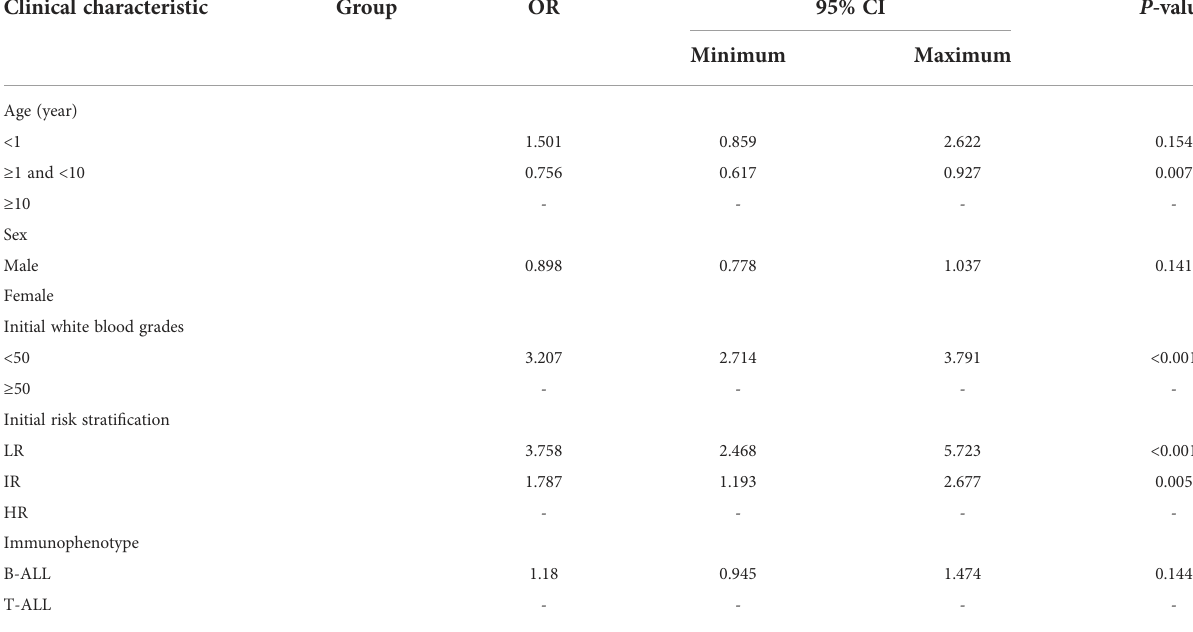
TABLE 2 Multivariate analysis of the clinical characteristics associated with dexamethasone response.